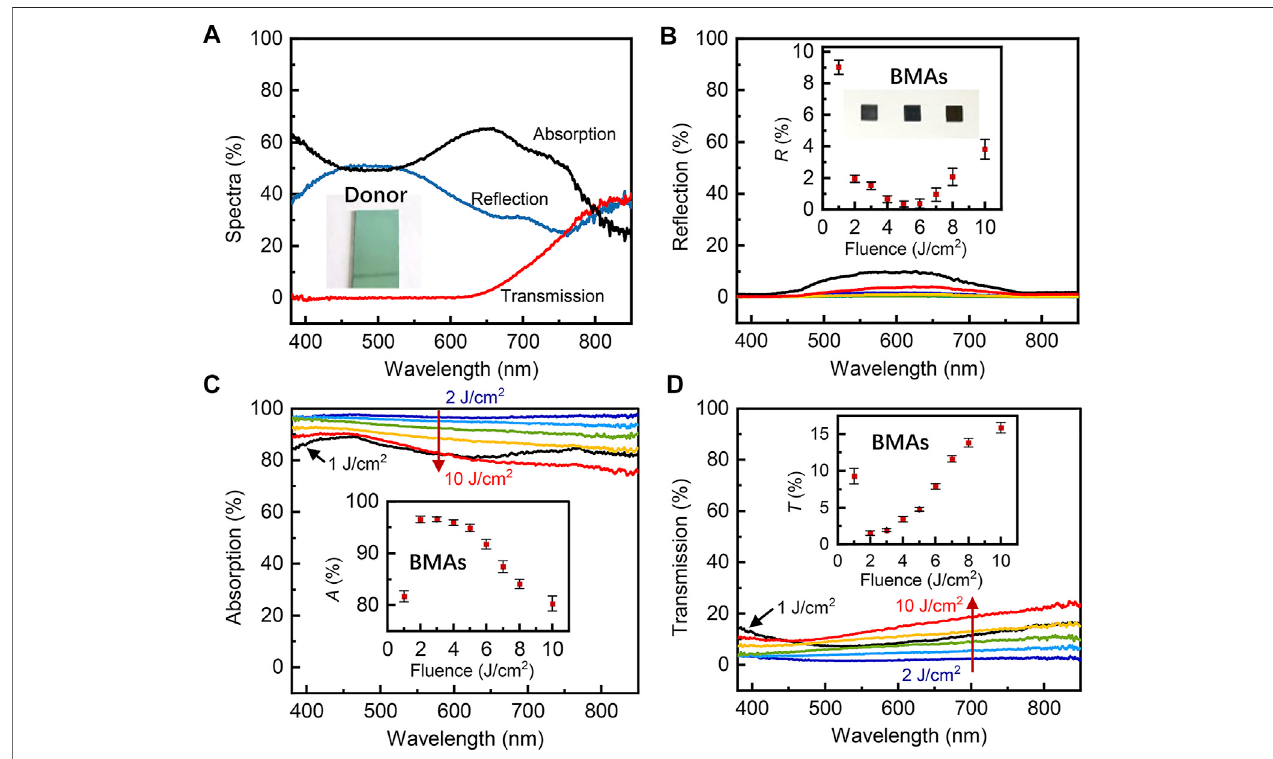
FIGURE5|(A) Opticalspectraofthedonor fi lm.Theinsetisthephotographofthedonor fi lm. (B) Re fl ectionspectraofthelaser-transferredBMA fi lms.Theinsetis the re fl ection at 633 nm as a function of laser fl uence. (C) Absorption spectra of the laser-transferred BMA fi lms. The inset is the absorption at 633 nm as a function of laser fl uence. (D) Transmission spectra of the laser-transferred BMA fi lms. The inset is the transmission at 633 nm as a function of laser fl uence.